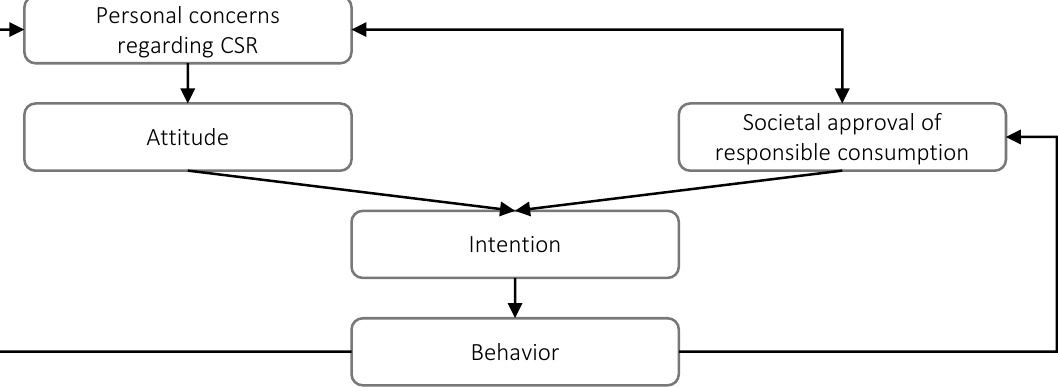
Figure 1. Adapted model of the decision-making process based on the merge of TRA and